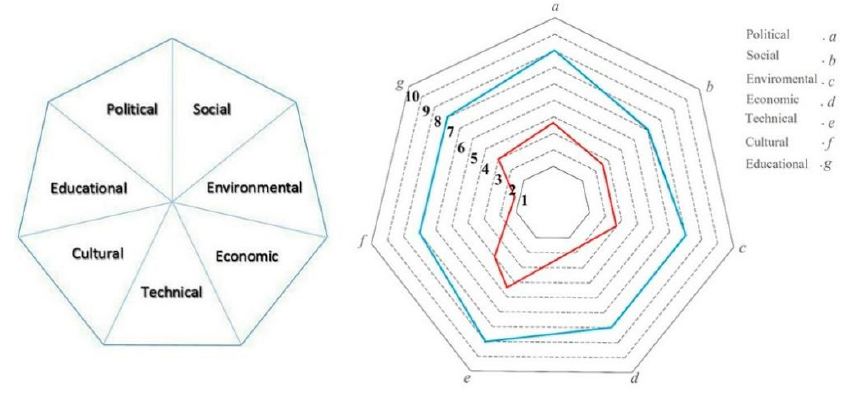
Figure 1. 7 PS Model [7,8].